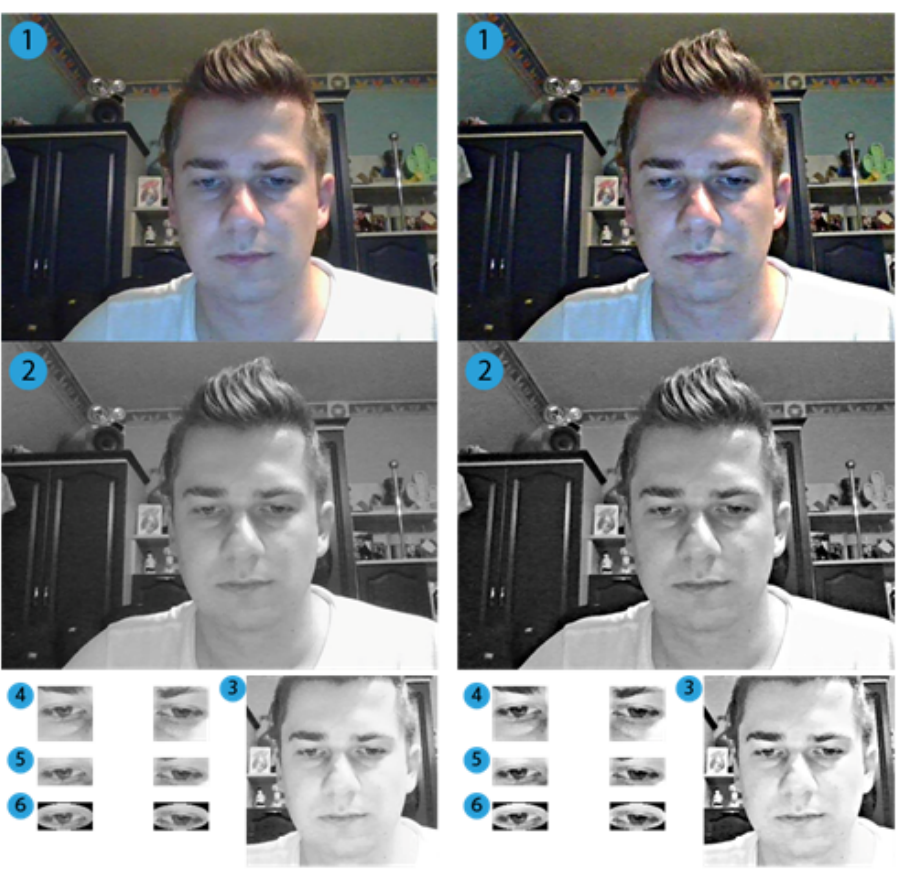
Figure 2. Stages of image